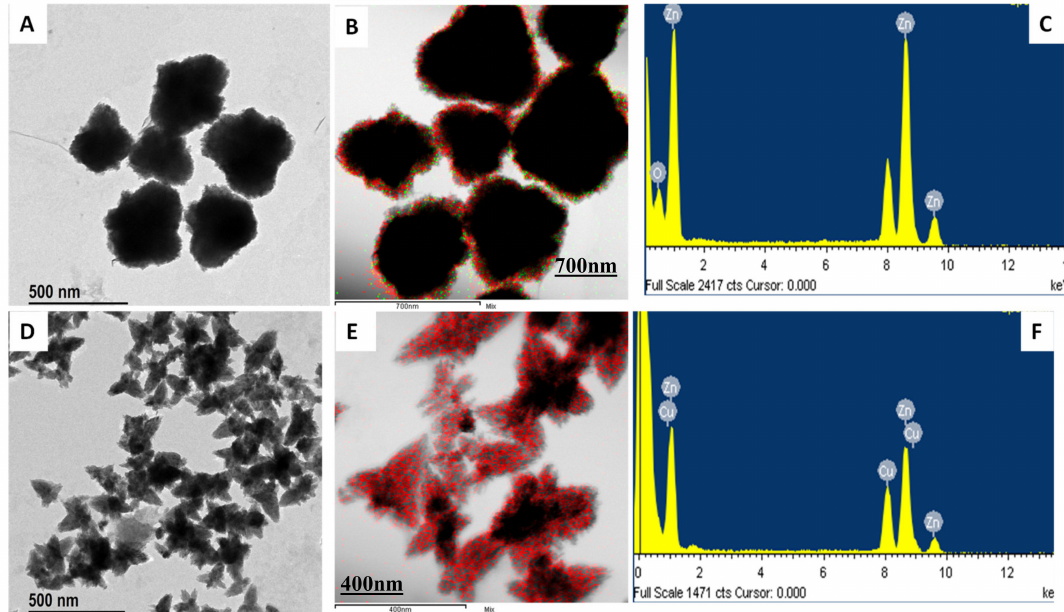
Figure 5. FE-TEM analysis of DM -ZnO nanoparticles, ( A ) Multiple images at 500 nm bar range (no aggregation), ( B ) Elemental mapping and DM -ZnO-I3C nanoemulsion, ( C ) EDS (Energy dispersive spectroscopy) of DM-ZnO nanoparticles, ( D ) Multiple images for DM-ZnO-I3C-NE at 500 nm range, ( E ) Elemental mapping, ( F ) EDS of DM -ZnO-I3C